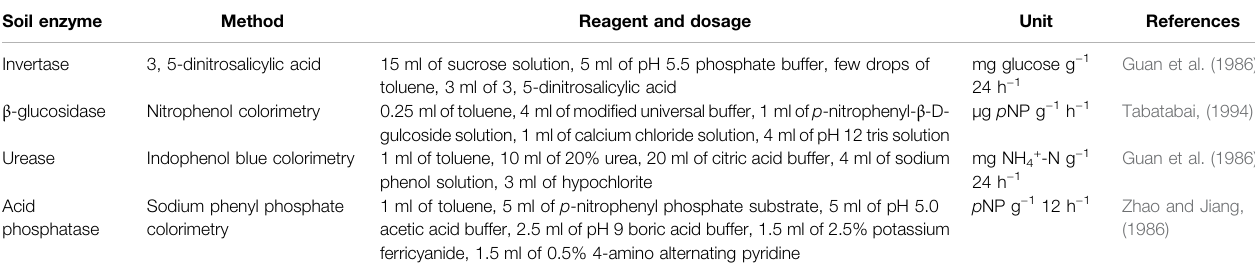
TABLE 2 | Reagent and method details for soil invertase, β -glucosidase, urease, and acid phosphatase. Soil